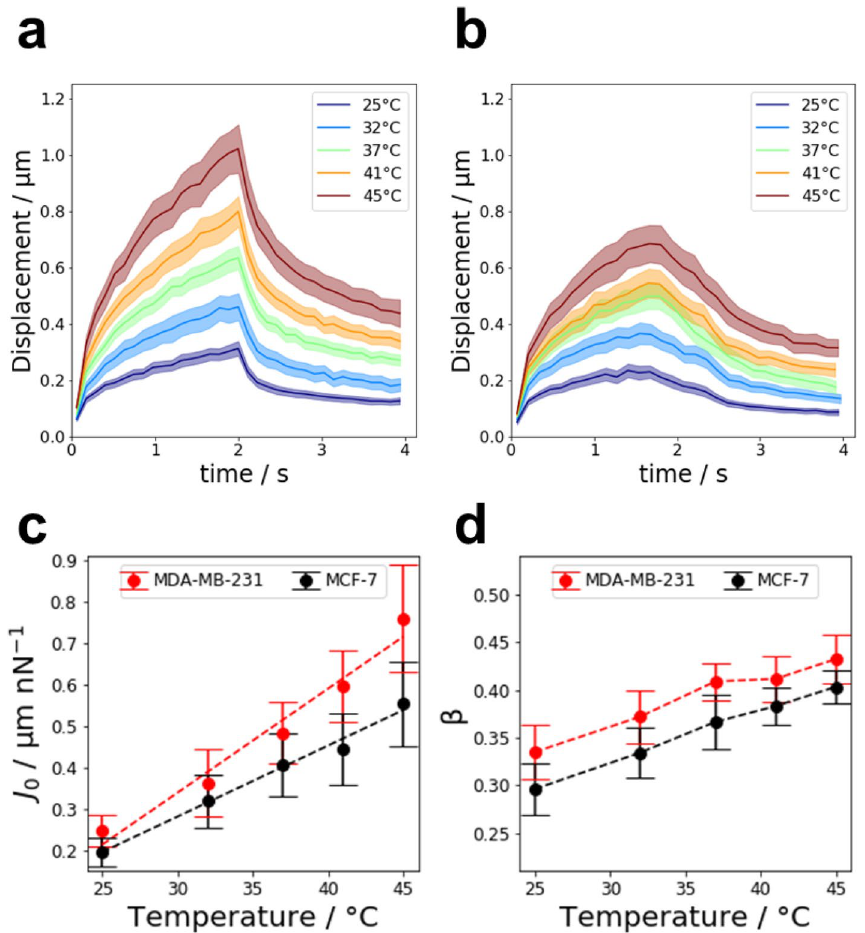
Figure 2. Response of MDA-MB-231 and MCF-7 cells to an increase in temperature from 25 to 45 °C. ( a ) Average displacement curves for 4.5 µm superparamagnetic beads coupled to MDA-MB-231 cells in response to a force of 1 nN. ( b ) Averaged creep curves for MCF-7 cells. The creep curves of both MCF-7 and MDA-MB-231 cells closely follow a power law. ( c ) Average creep compliance of MDA-MB-231 and MCF-7 cells as a function of temperature. The average creep compliance was derived from the pre-factor of a power law fit to the respective creep curves. For both cell lines, the creep compliance increases linearly with temperature. ( d ) Average cell fluidity of MDA-MB-231 and MCF-7 cells. The cell fluidity β is the exponent of the power law fit to the creep curves. Both cell lines become more fluid-like as the temperature